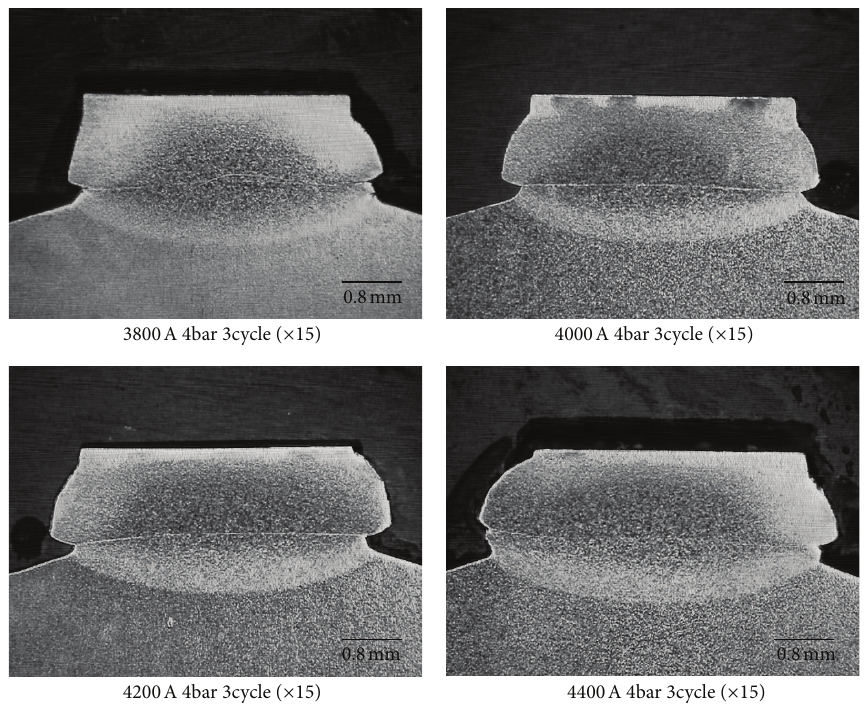
Figure 11: Macrocross sections of the nugget welds in end-plate to end cap joint ( × 15).